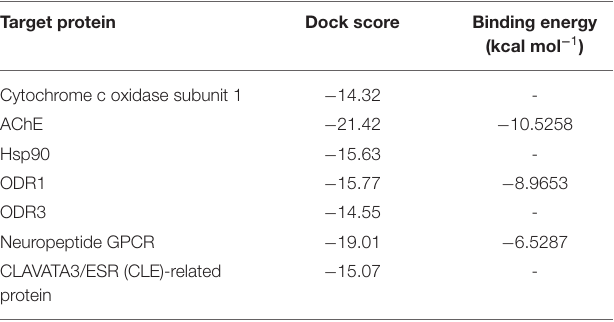
TABLE 3 | In silico docking results of allyl isothiocyanate (AITC) against M. incognita target proteins. Target